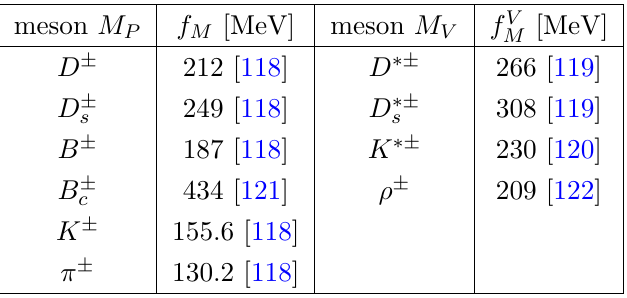
Table 8 . Decay constants for charged pseudoscalar and vector mesons.